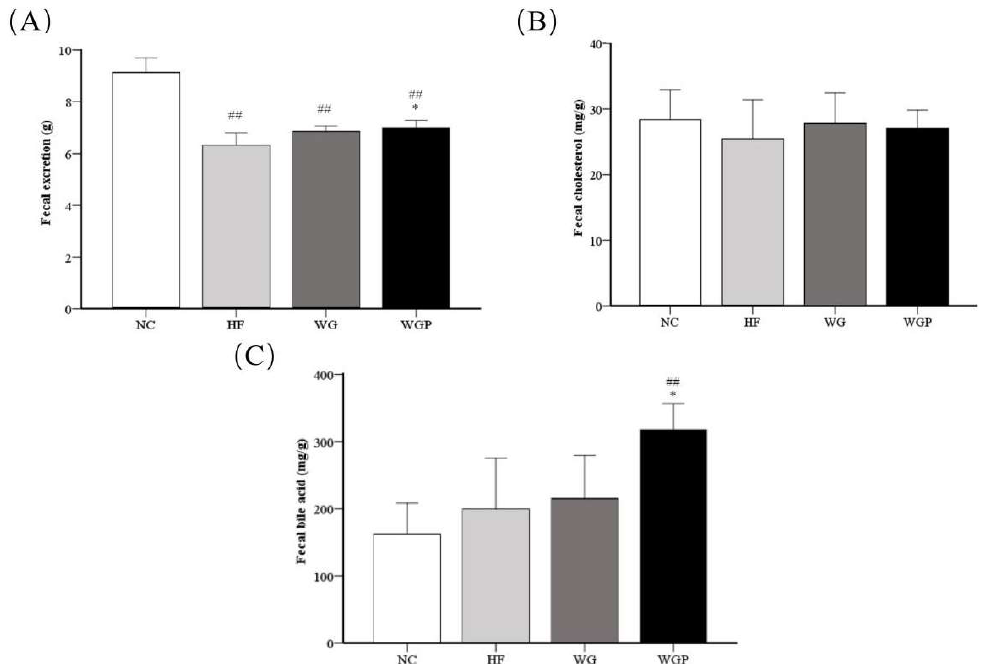
Figure 4. Analysis of fecal excretion ( A ), fecal cholesterol ( B ) and fecal bile acid ( C ) in high-fat diet-induced rats after 4 weeks. Values are presented as means ± SEMs ( n = 5). ## p < 0.01 vs. NC group. * p < 0.05 vs. HF group.